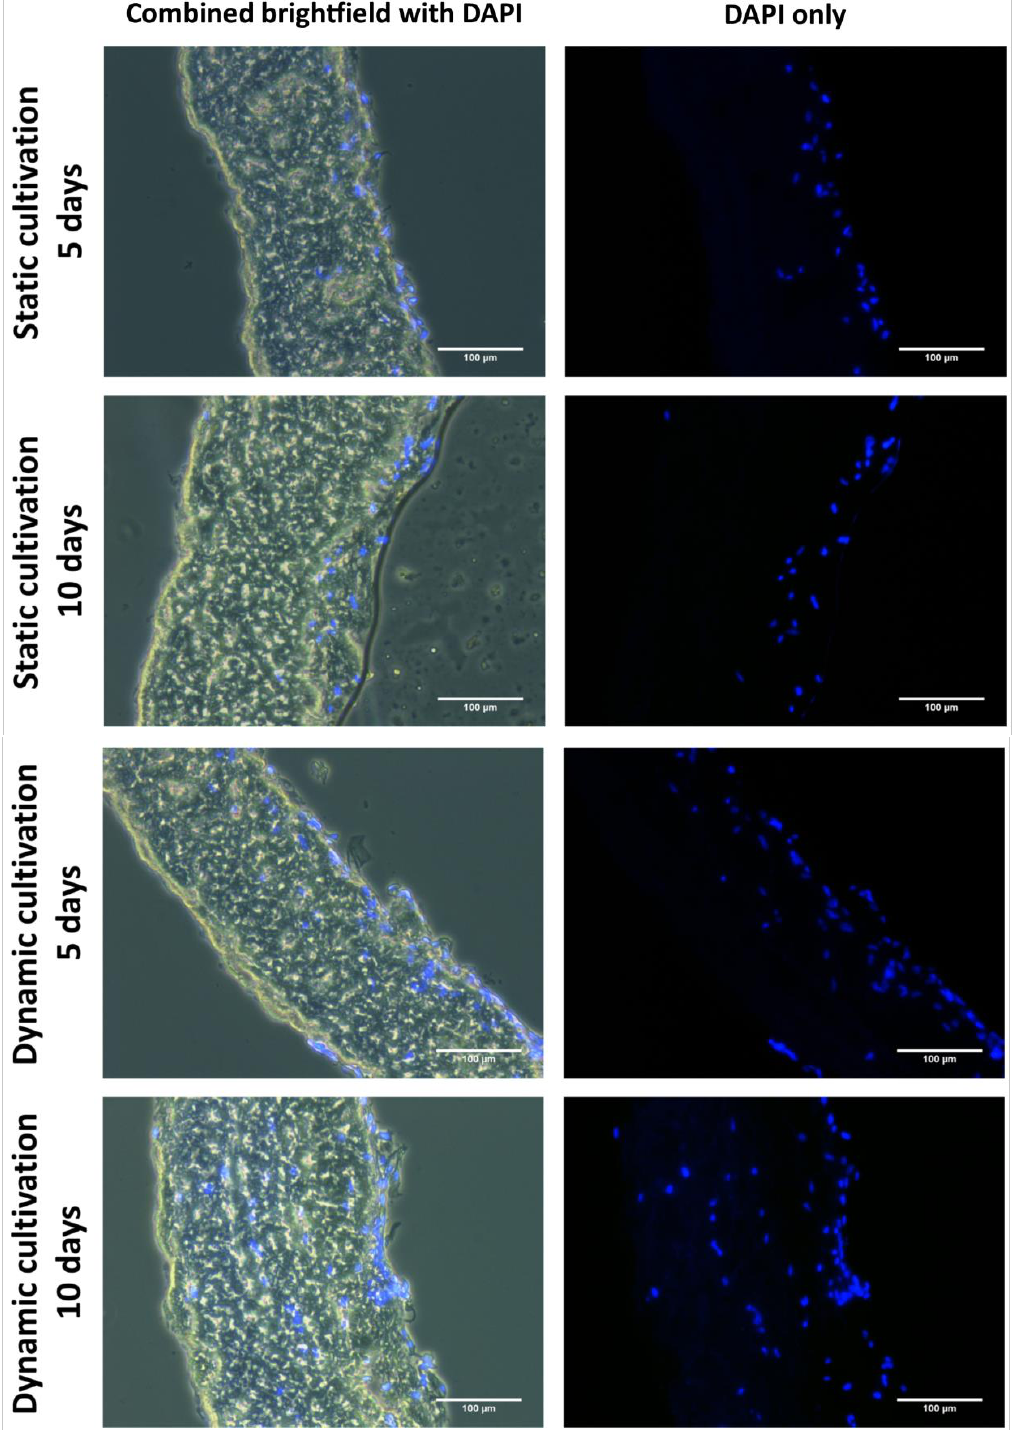
Figure 7. DAPI counterstained cryosections of recellularized tissues cultivated in static and dynamic conditions for 5 days and for 10 days. Tissues prior to cultivation were seeded from a single side of decellularized tissue. The microscope used Leica DMi 8, 10 ×